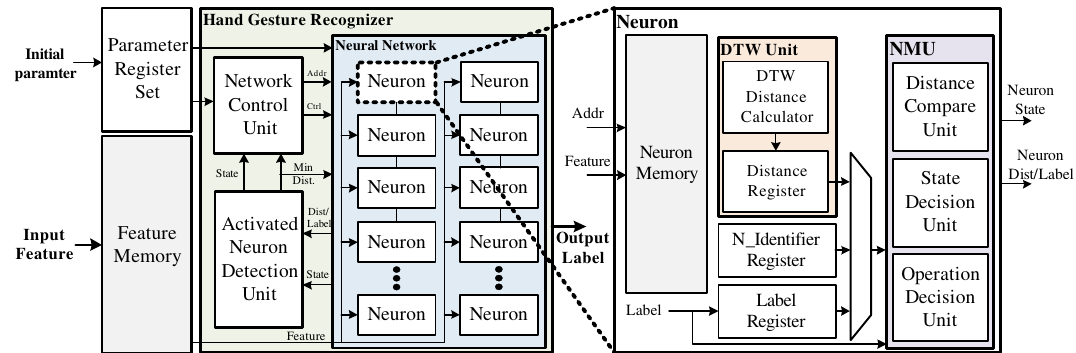
Figure 9. Block diagram of the proposed hand gesture